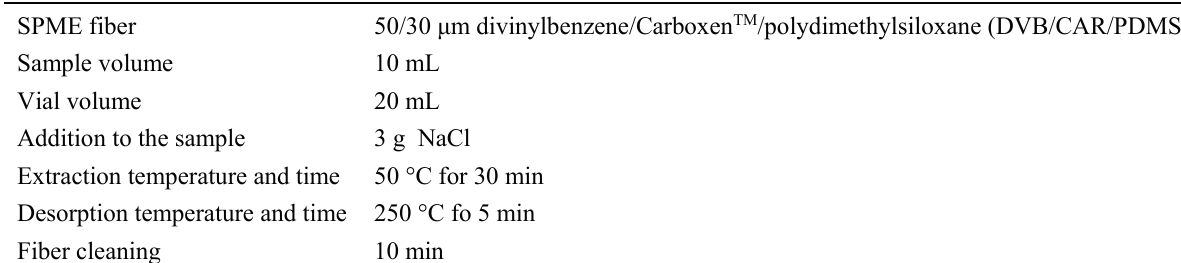
Table 5. HS-SPME conditions used for simultaneous analysis of “foxy smelling compounds” ( o -AAP and MA) and 3-alkyl-2-methoxypyrazines (ETMP, IPMP, IBMP, and SBMP) in grape juice [73].